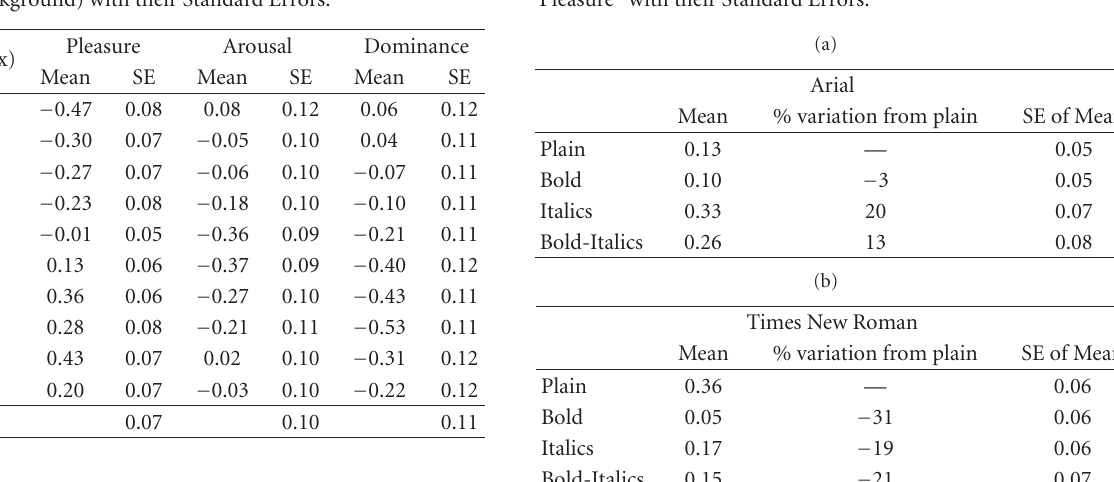
Table 6: Mean values of font style and the percentage variations from plain text using Arial (a) or Times New Roman (b) on “Pleasure” with their Standard